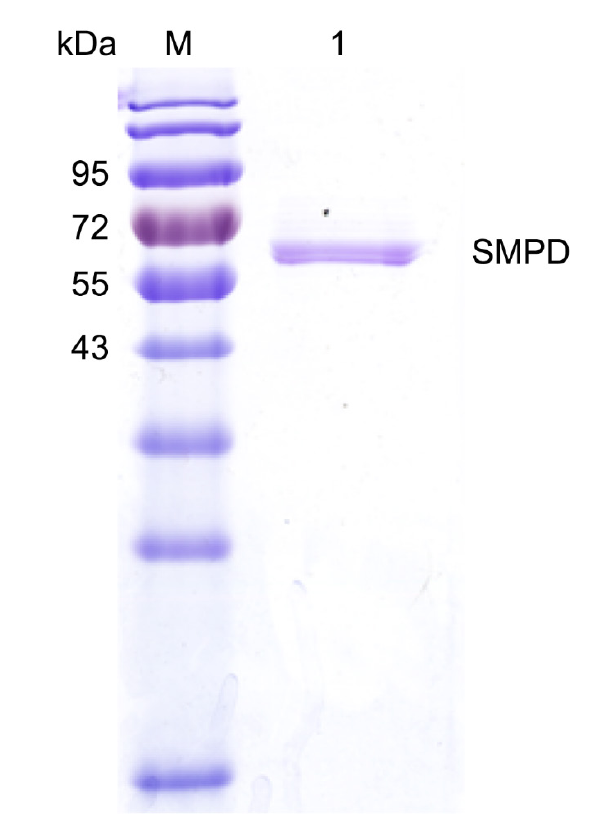
Fig 3 . SDS-PAGE profile of SMPD expressed in p GEX-6P-1 /BL21 system. M, protein molecular weight standards; lane 1, protein expressed in BL21 cell with p GEX-6P-1 -SMPD plasmid; lane 2, protein expressed in BL21 cell with un-induced p GEX-6P-1 -SMPD plasmid; lanes 3 and 4, protein expressed in BL21 cell with induced and un- induced p GEX-6P-1 plasmid respectively.